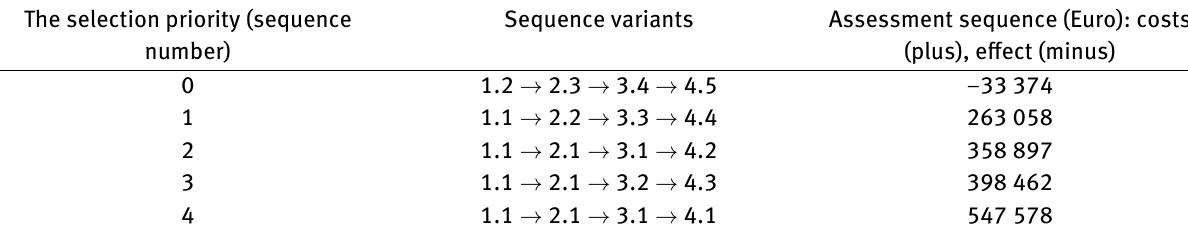
Figure 7: The example of the equipment options’ «tree» of rail node by RFID readers. Table 1: The optimal sequence (phasing) of the options. The selection priority